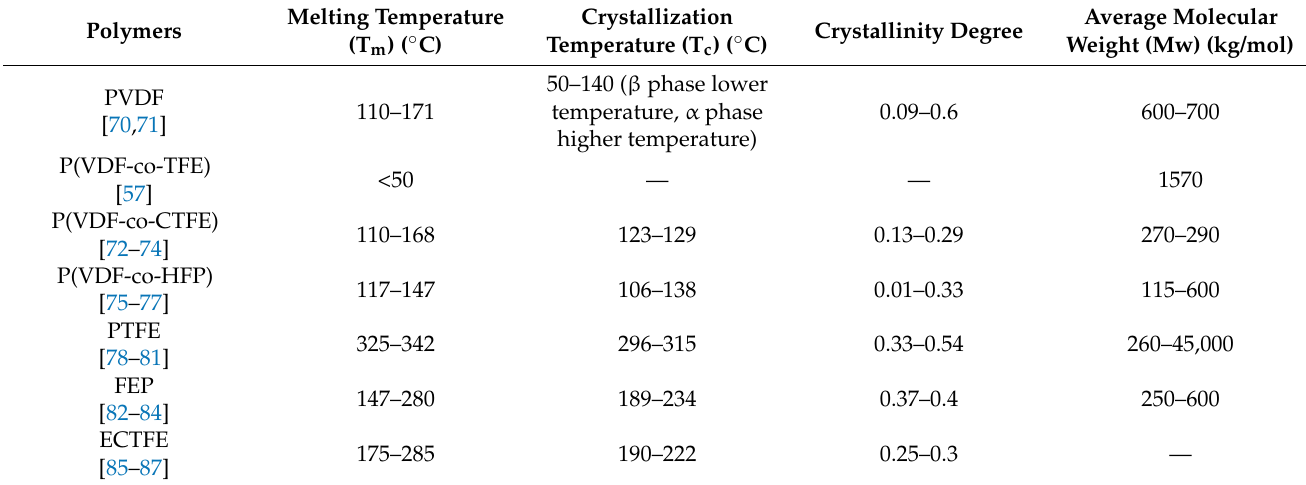
Table 3. Chemical properties of fluoropolymers for MD and